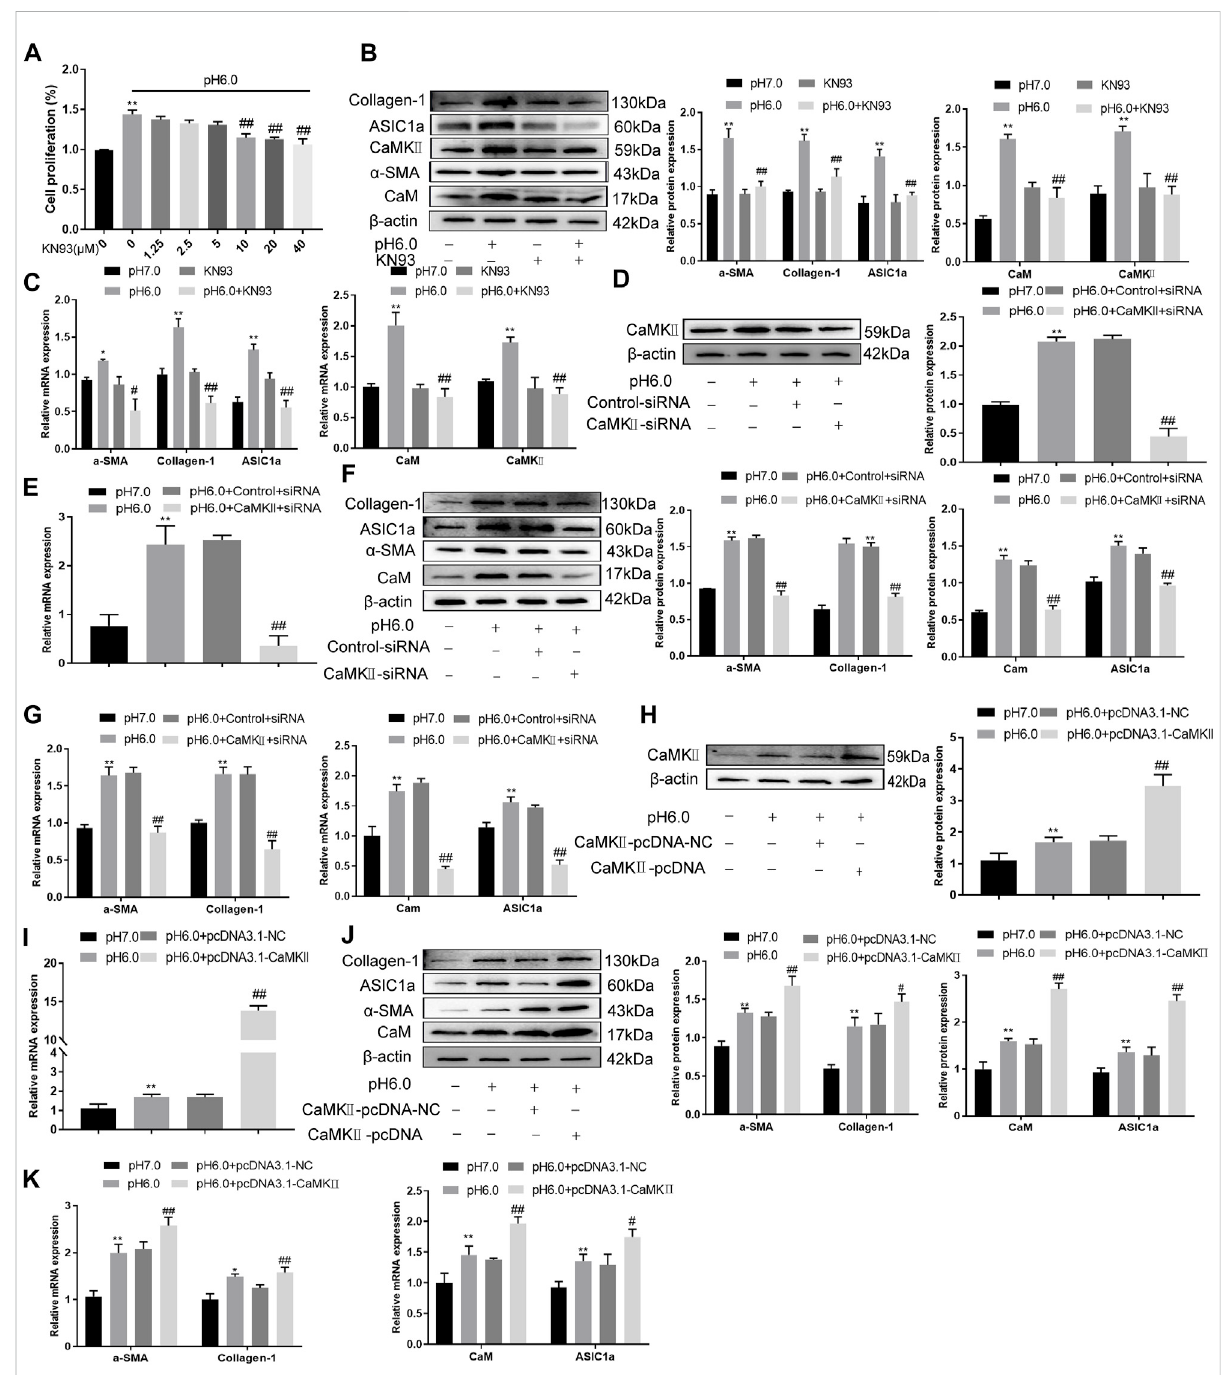
KN93 can inhibit the expression of CaM/CaMK Ⅱ in HSC-T6. (A) CCK-8 method was used to detect the effect of KN93, a speci fi c inhibitor of CaMK Ⅱ , on acid-induced hematopoietic stem cell proliferation. (B) Western blotting was used to detect the levels of fi broproteins, CaM, and CaMK Ⅱ in HSCs treated with KN93. (C) qRT-PCR was used to detect the mRNA levels of fi broproteins, CaM and CaMK Ⅱ in HSCs treated with KN93. (D) After CaMK Ⅱ wassilenced,CaMK Ⅱ proteinlevelsinHSCsweredetectedbyWesternblotting. (E) AftersilencingCaMK Ⅱ ,themRNAlevelofCaMK Ⅱ was detected by qRT-PCR. (F) After silencing CaMK Ⅱ , the levels of CaM and fi brosis protein in HSCs. (G) mRNA levels of CaM and fi broproteins in HSCs aftersilencingCaMK Ⅱ . (H) ThelevelofCaMK Ⅱ proteininHSCswasdetectedbyWesternblottingafteroverexpressionofCaMK Ⅱ . (I) ThemRNAlevelof CaMK Ⅱ in HSCs was detected after overexpression of CaMK Ⅱ . (J) Detection of CaM and fi brosis protein expression in HSCs after overexpression of CaMK Ⅱ . (K) mRNAlevelsofCaMand fi broproteinsinHSCsafteroverexpressionofCaMK Ⅱ .Dataareexpressedasthemean±SD( n ≥ 3).* p < .05,** p < .01 vs. Control group; # p < .05, ## p < .01 vs. pH 6.0